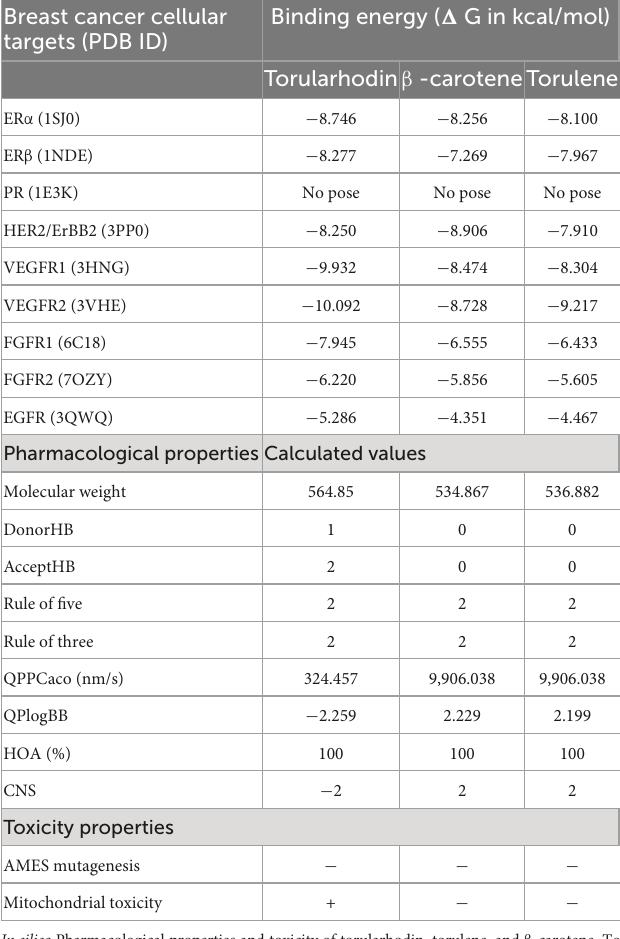
TABLE 1 Calculated binding energy of torularhodin, torulene, and β -carotene. Breast cancer cellular Binding energy ( (cid:49) G in kcal/mol) targets (PDB ID) Torularhodin β